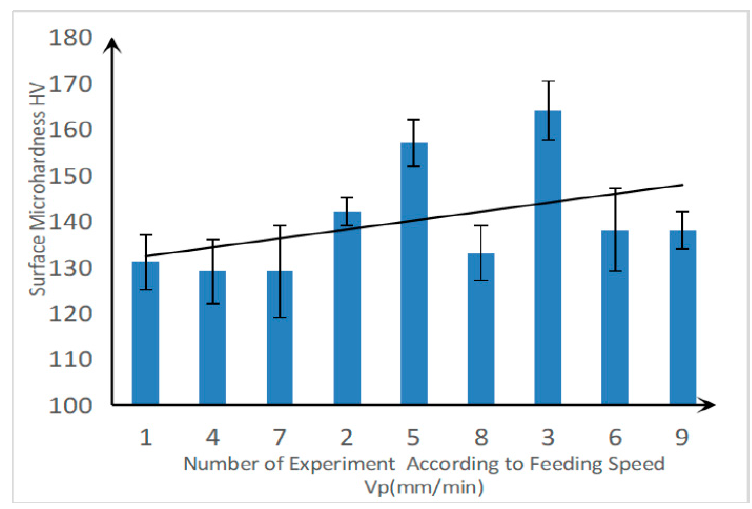
Figure 19. Relationship between the surface micro-hardness and the feed rate of the grinding head.